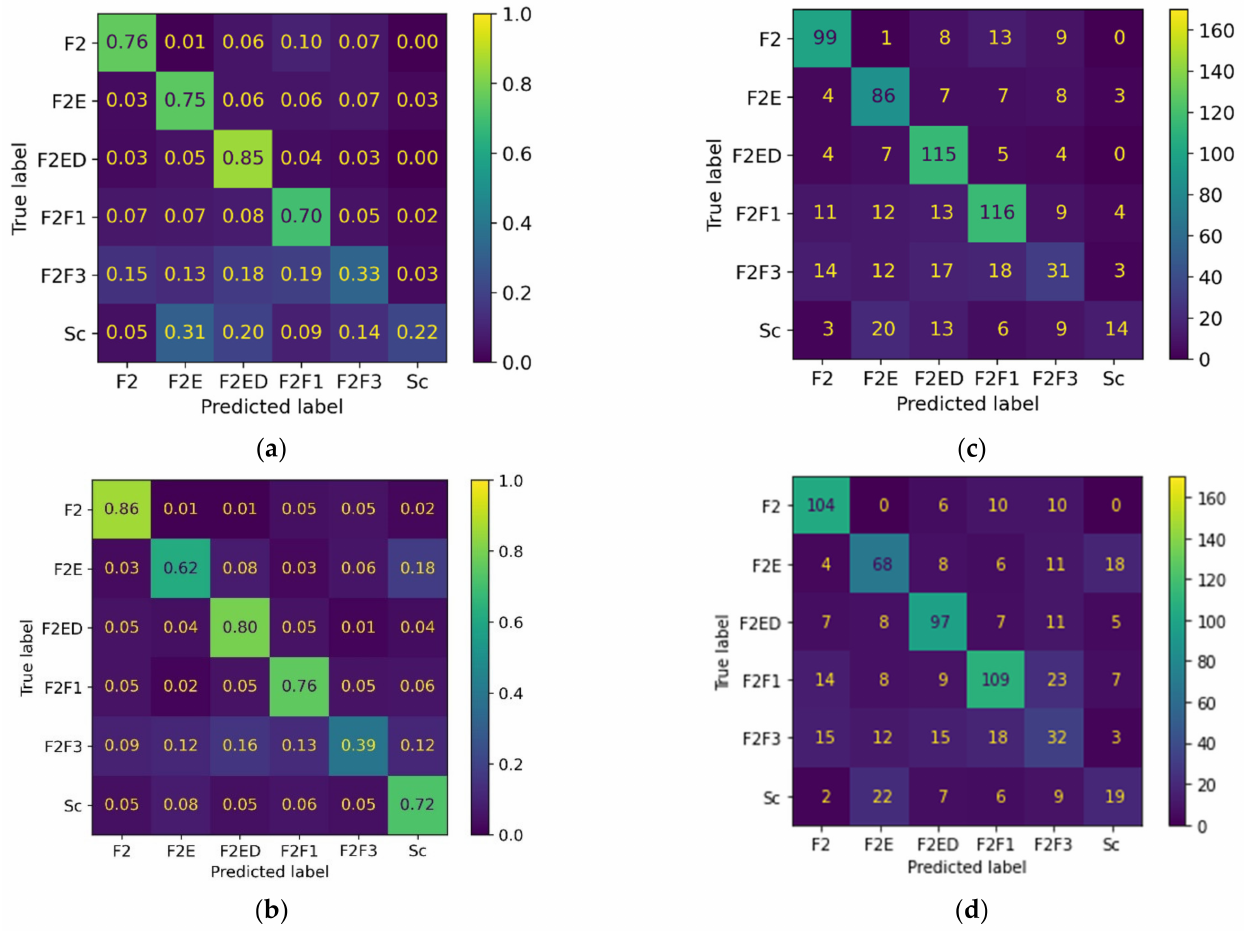
Figure 4. The confusion matrices of six classes averaged over five subsets of the cross-validation. Panels ( a , b ) show C CV , the ratio of cases for a ground truth label i predicted as label j, for our CNN ij and FCN model, respectively. Panels ( c , d ) show the number of cases for a ground truth label i predicted as the label j for the CNN and FCN models, respectively. The colors from dark blue to yellow correspond to the ratios from 0 to 1 or absolute numbers from 0 to